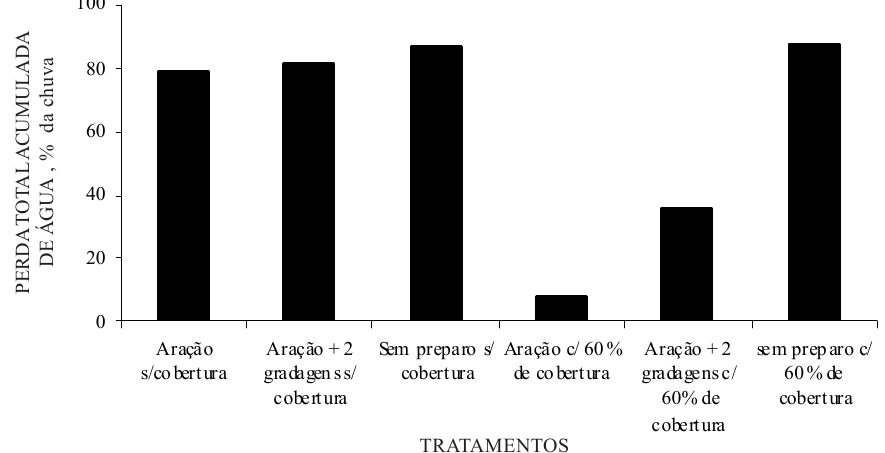
Figura 3. Perda total acumulada de água nos testes de chuva contínua (T2 + T3 + T4), de longa duração (90 min), nos tratamentos